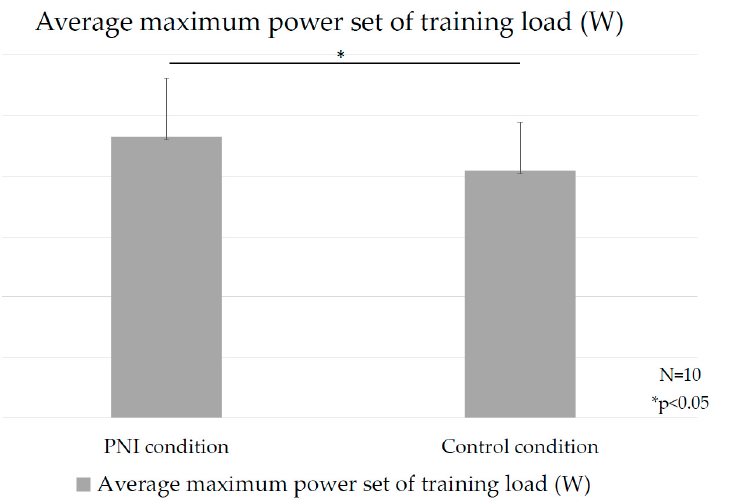
Figure 7. Comparing the average of training load (W) during the maximum power set in PNI and control conditions.